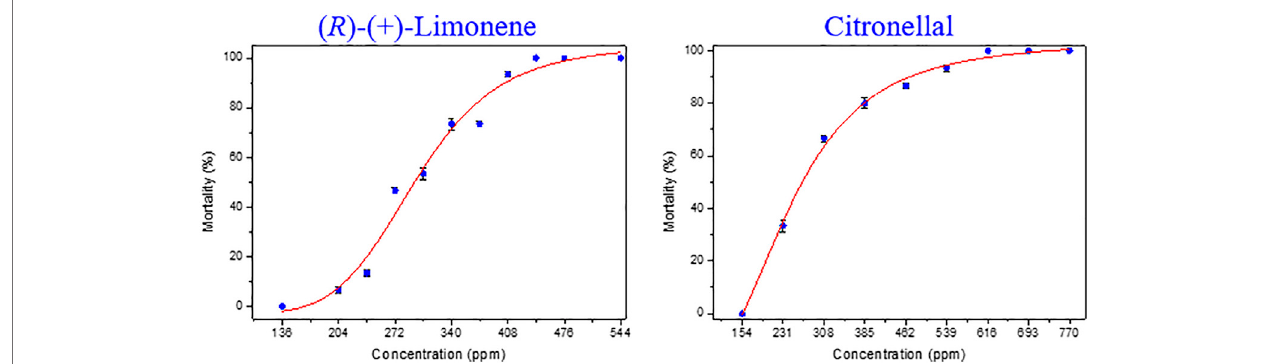
FIGURE 5 | Toxicity curve of the two chemotypes against Ae. albopictus .